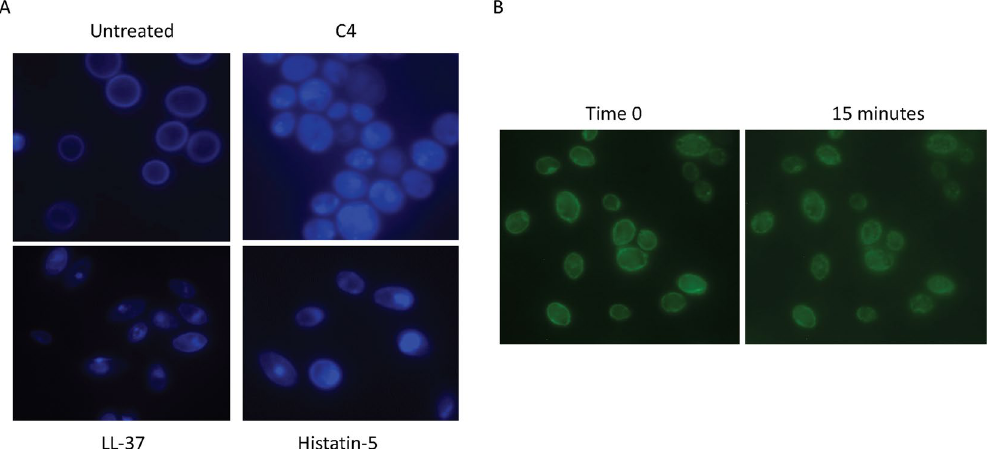
Figure 3. Visualization of membrane activity by fluorescence microscopy. ( A ) Filipin staining. C. albicans (approx. 3.4 × 10 6 cfu/ml) were stained with filipin, and treated with the compounds listed at 32 µ g/ml, and visualized under fluorescent microscopy (magnification = 1000X). Shown are representative images of Candida taken after 10 minutes. ( B ) GFP visualization C. albicans expressing a Pma1-GFP fusion protein in the membrane were seeded onto plates coated with concanavalin A (1 mg/ml) and treated with either histatin 5 or C4 at 32 µ g/ml and visualized at time 0 and after 15 minutes.